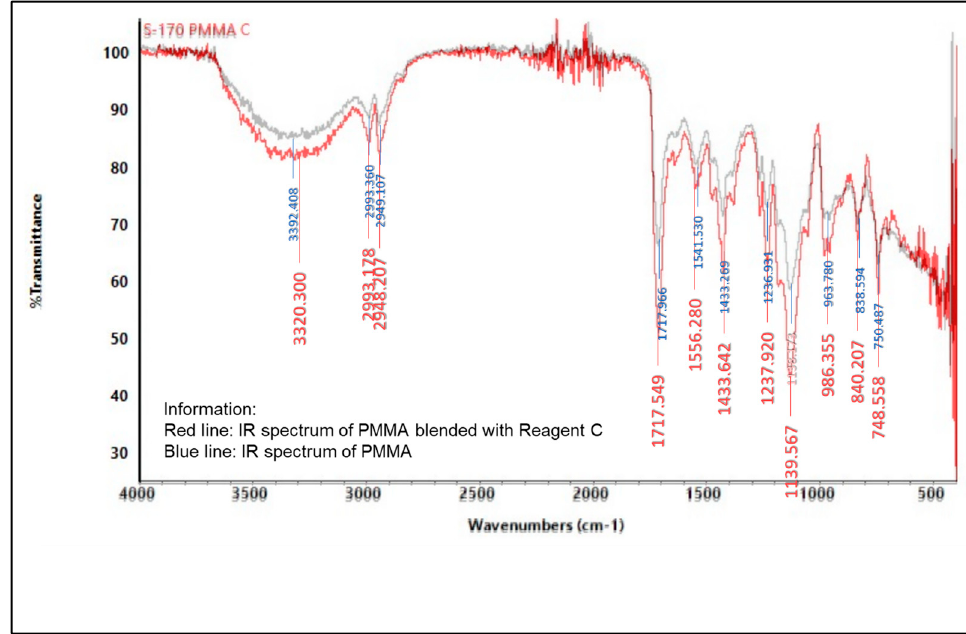
Figure 5. IR spectrum comparison of pure PMMA and blended PMMA with reagent B (concentrated HCl).